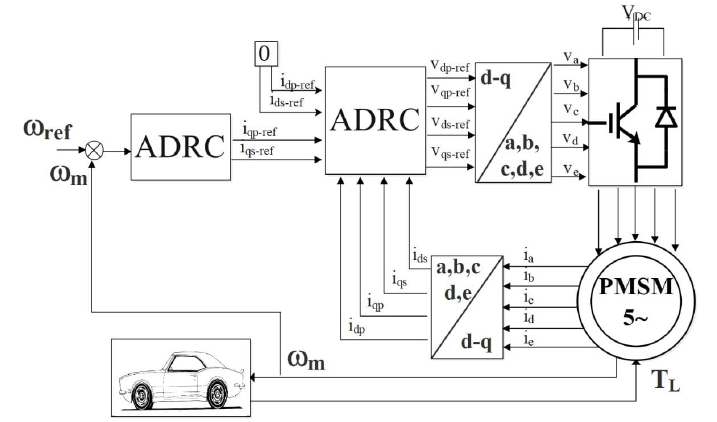
Figure 1. Block diagram of ADRC for a 5-phase